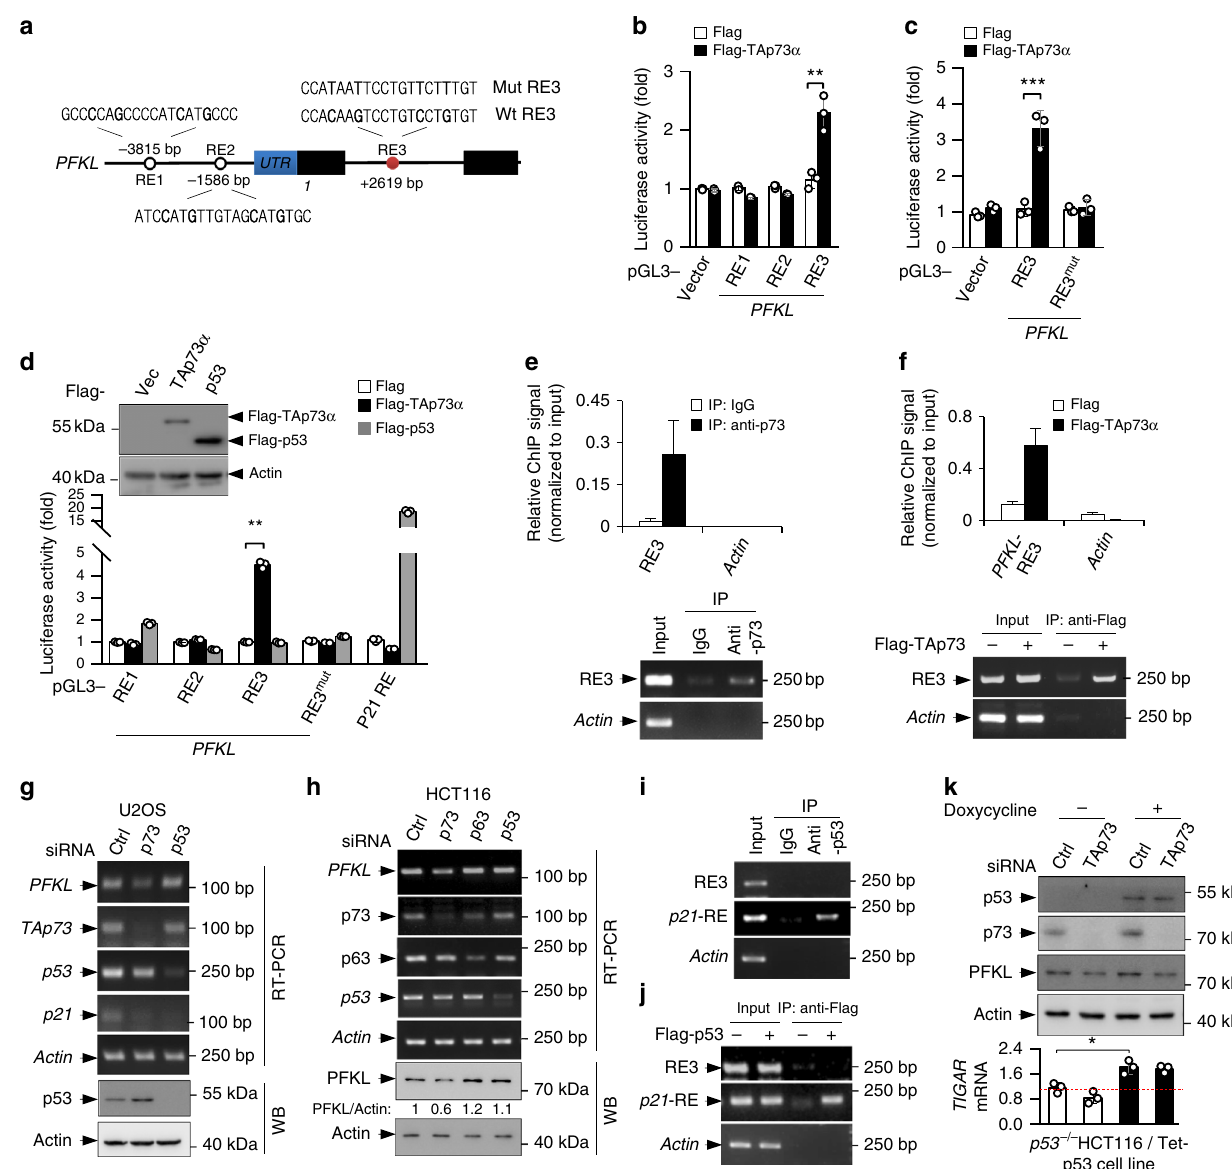
Fig. 4 PFKL is a physiologically relevant target of TAp73. a Schematic representation of human PFKL genomic structure. The sequences of potential p73 response elements RE1 – 3 and the corresponding mutant RE3 are shown. b , c Luciferase constructs containing RE1, RE2, and RE3 ( b ), or RE3 and mutant RE3 ( c ) were transfected into 293T cells together with Flag-TAp73 α or vector control. Renilla vector pRL-CMV was used as a transfection internal control. The relative luciferase activity was normalized to the co-transfected Renila activity. Data are means± S.D. ( n = 3). d Luciferase reporter constructs containing RE1, RE2, RE3, or RE3mut were transfected into 293T cells together vector control, p53, or TAp73. Renilla vector pRL-CMV was used as a transfection internal control. Relative levels of luciferase are shown. Data are means ± S.D. ( n = 3). Insert shows protein expression. e , f U2OS cells ( e ), or 293T